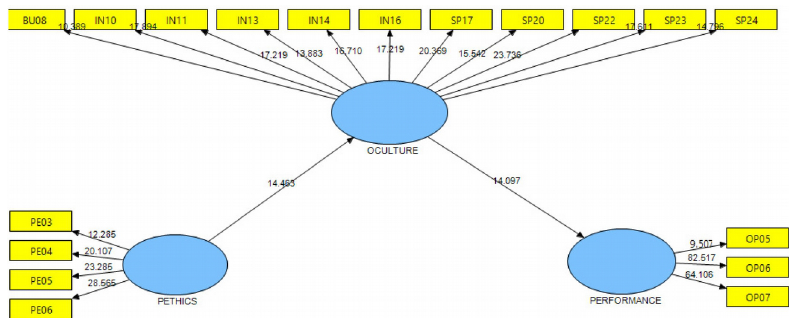
Figure 4. Mediation